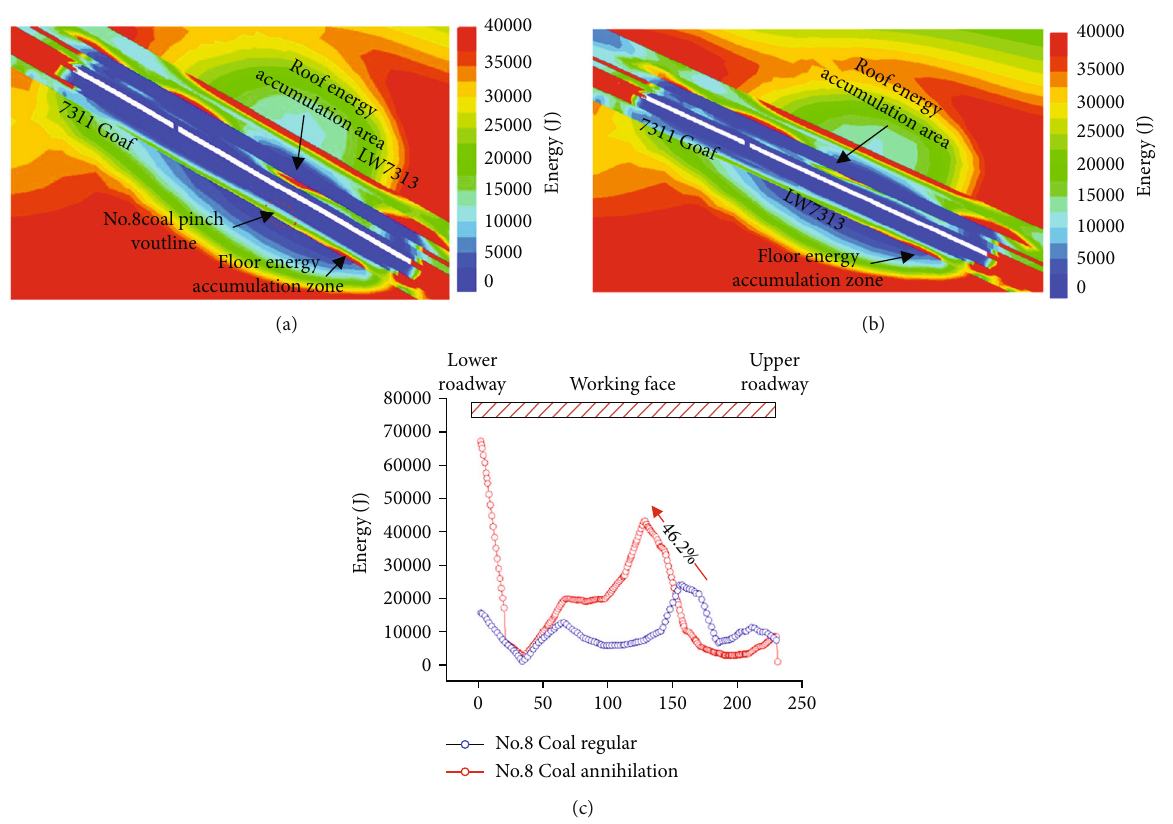
Figure 13: Energy distribution of inclined suspended roof: (a) scheme ① with No. 8 coal missing area; (b) scheme ② without No. 8 coal missing area; (c) energy evolution curve of the working face roof